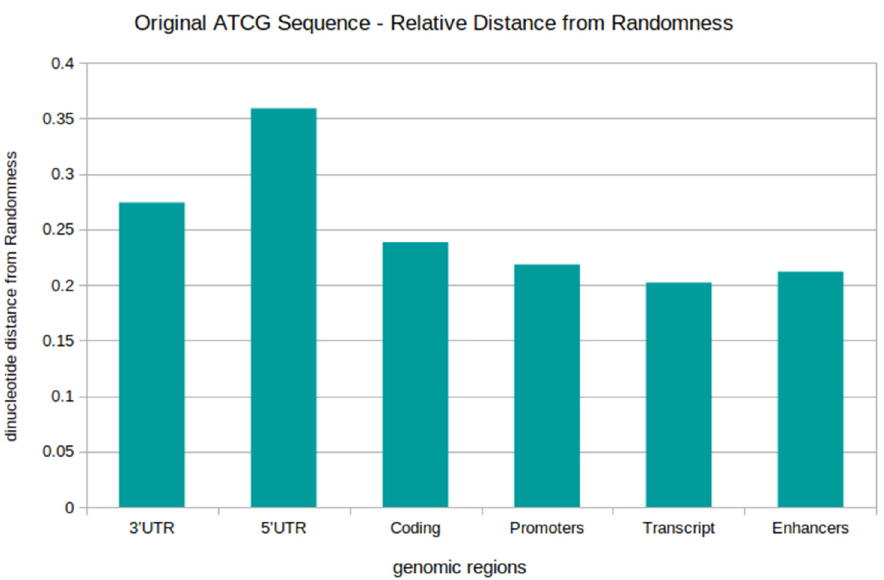
Figure 2. Distance from randomness of different genomic regions for the ATCG original sequence: The profile shows the average (mean) distance from randomness values of the different genomic DNA sequences, within a given region. The sequences analysed include the 3 ′ UTR, 5 ′ UTR, coding, promoter, transcript, and enhancer. A value of zero denotes the random model, and the further away the values from zero, the greater the distance from randomness. The different genomic regions each display a distinct distance from randomness value and profile; however, all are non-random in nature. This reflects that the difference in profiles reflects sequence properties and patterns of each region. The UTR’s are most distant from the random model with respect to all the possible dinucleotides, with the 5 ′ UTR being the most non-random in nature, followed by the 3 ′ UTR. This is then followed by coding sequences. Promoter and enhancers are relatively similar, and transcript is closest to ‘randomness’. Overall, this demonstrates that different genomic regions, with different functionalities, possess distinct sequence features, in a general sense, and this is likely due to functionality itself with its own encoding, as well as distinct sequence assembly and evolutionary constraints.